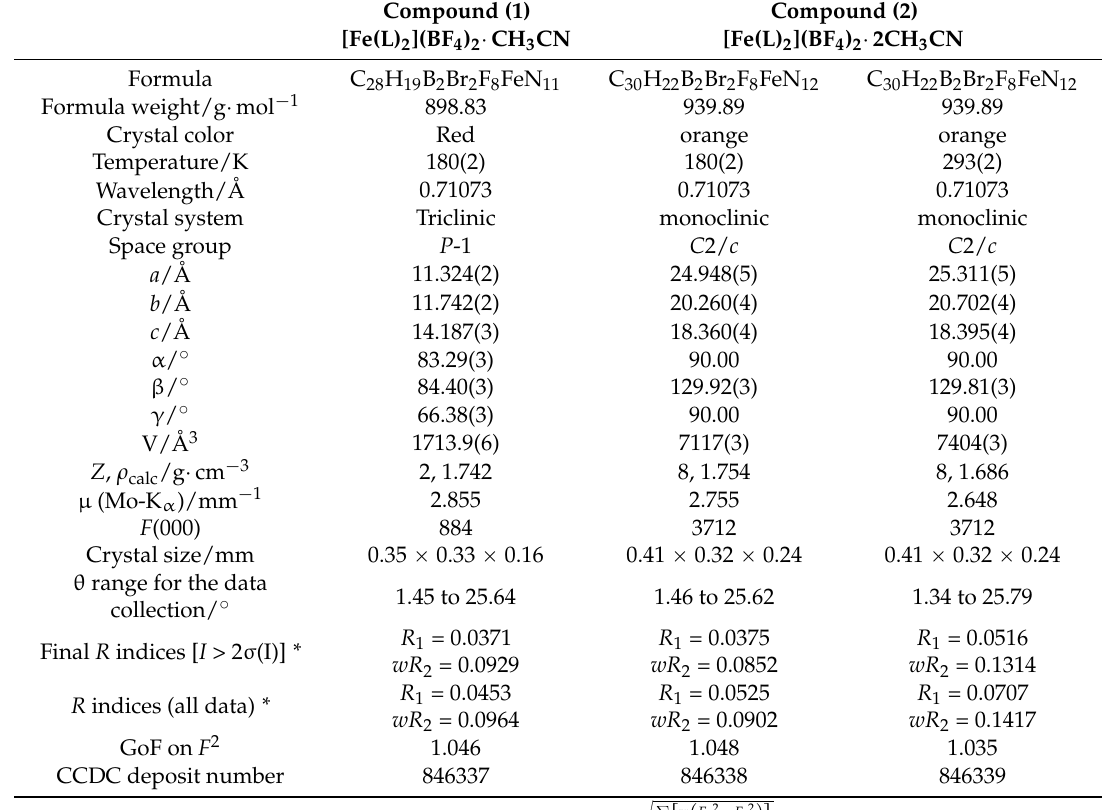
Table 1. Crystal structure parameters for compounds ( 1 ) and ( 2 ).